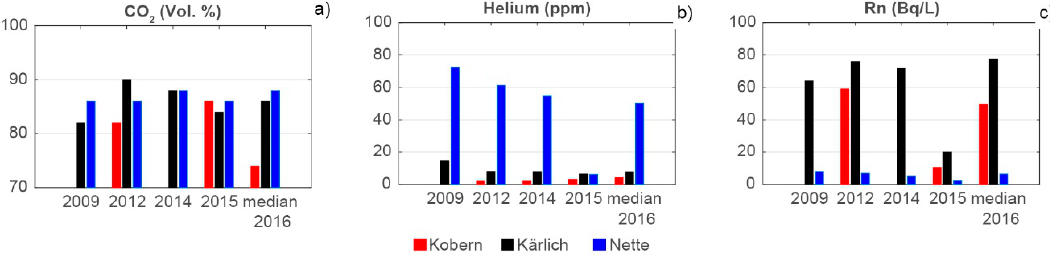
Figure 4. Concentrations of ( a ) CO 2 (Vol.%), ( b ) Helium (ppm), and ( c ) Radon (Bq / L) in Nette, Kärlich and Kobern between 2009 and 2016. Concentrations for 2009–2015 are from [60] and unpublished data for 2014 and 2015 by G.M. Berberich.